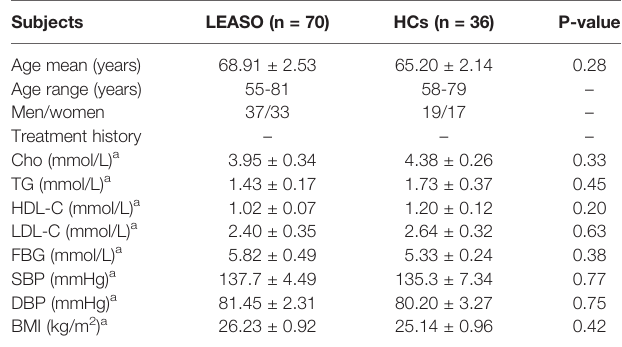
TABLE 1 | Clinical characteristics of enrolled